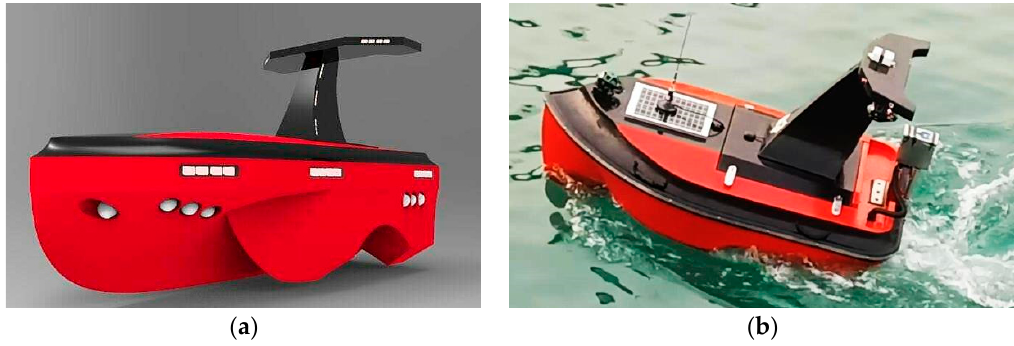
Figure 11. A self-developed unmanned surface vehicle: ( a ) 3D model; ( b ) USV in water.